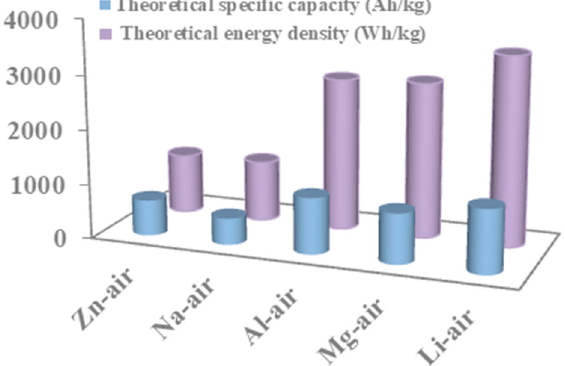
Figure 1. The theoretical specific capacity and theoretical energy density of various types of metal– air battery.